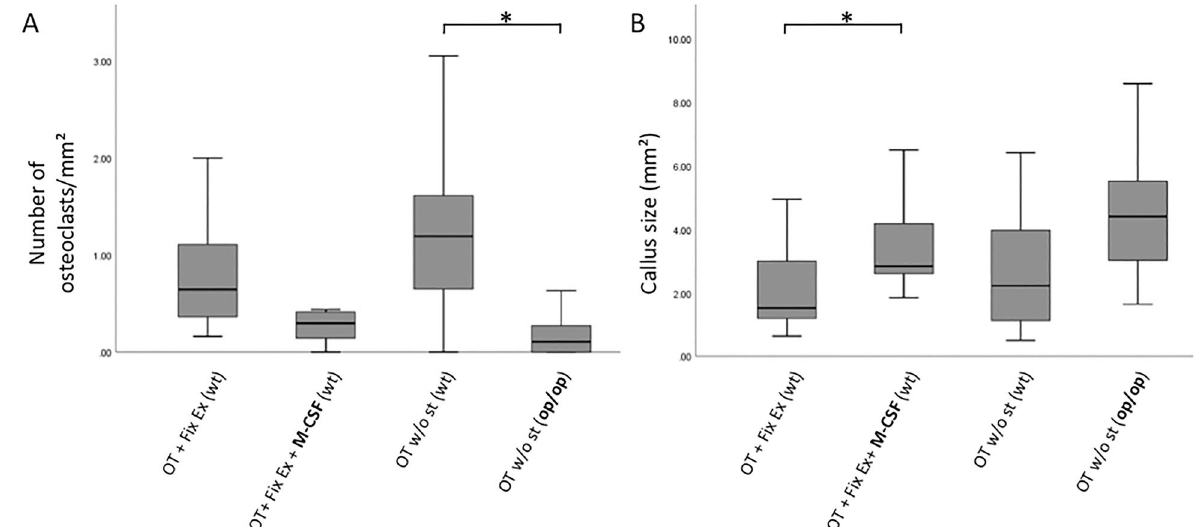
Figure 3. ( A , B ) Histologic analysis revealed op/op mice (group 4) displayed significantly less osteoclasts/mm 2 compared to wt mice (group 3) (P = 0.001) (both groups without additional stabilization). M-CSF treatment had a striking effect on callus size compared to wt mice without M-CSF treatment (P = 0.043). M-CSF